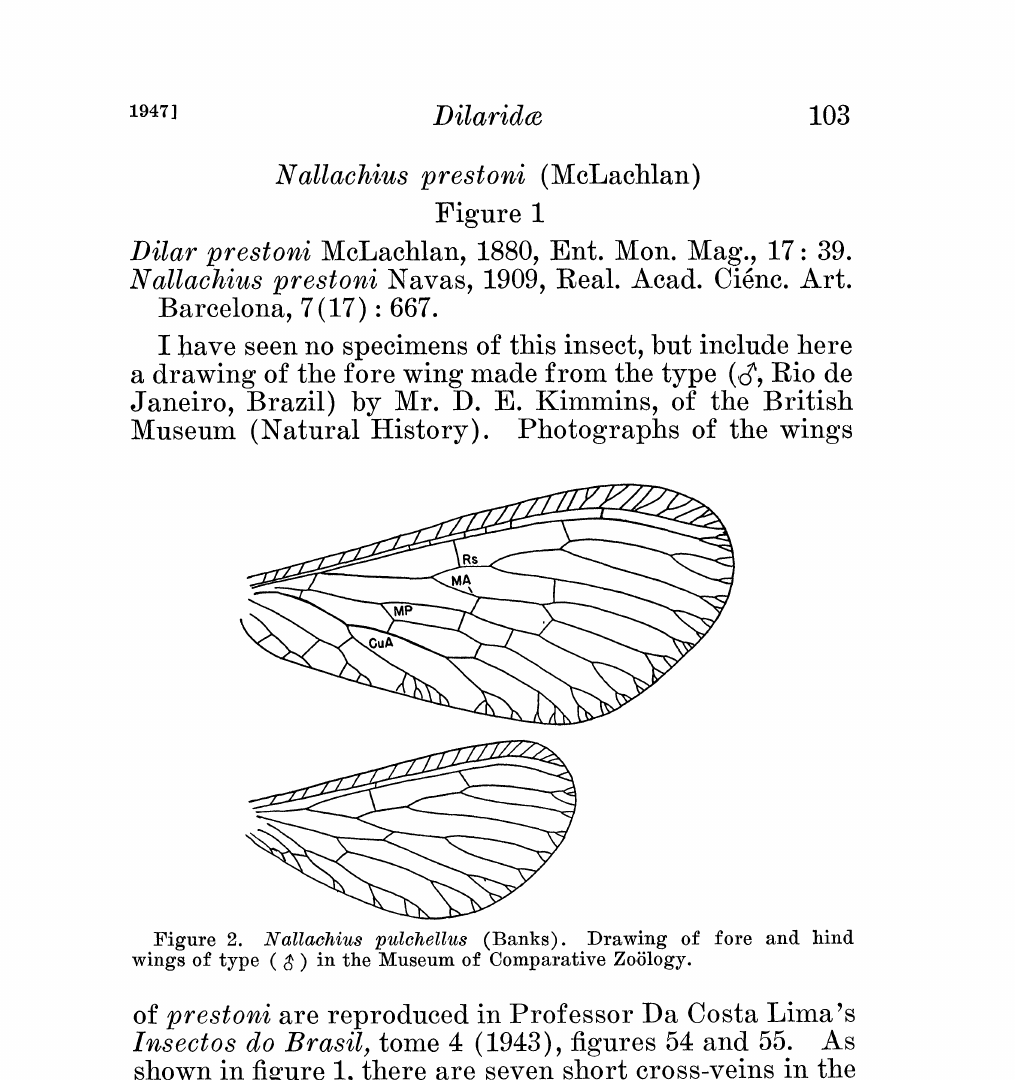
Figure 2. Nallachius pulchellus (Banks). Drawing of fore and hind wings of type 3 in the Museum of Comparative